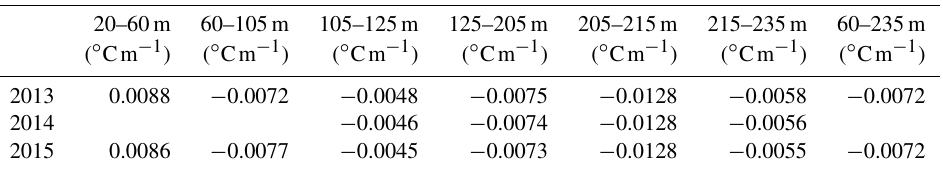
Figure 5. Synthetic data for three past years (2013, 2014 and 2015). It can be seen that the inversion in the last 50 years is more accurate than the inversion of Fig. 4. Legend: 0.15: green line; 0.2: orange line; 0.25: red line. Table 1. Thermal gradients ( ◦ Cm − 1 ) in 2013, 2014 and 2015 in the different depth intervals of the profile below the zero annual amplitude that is approximately at 20m of depth.